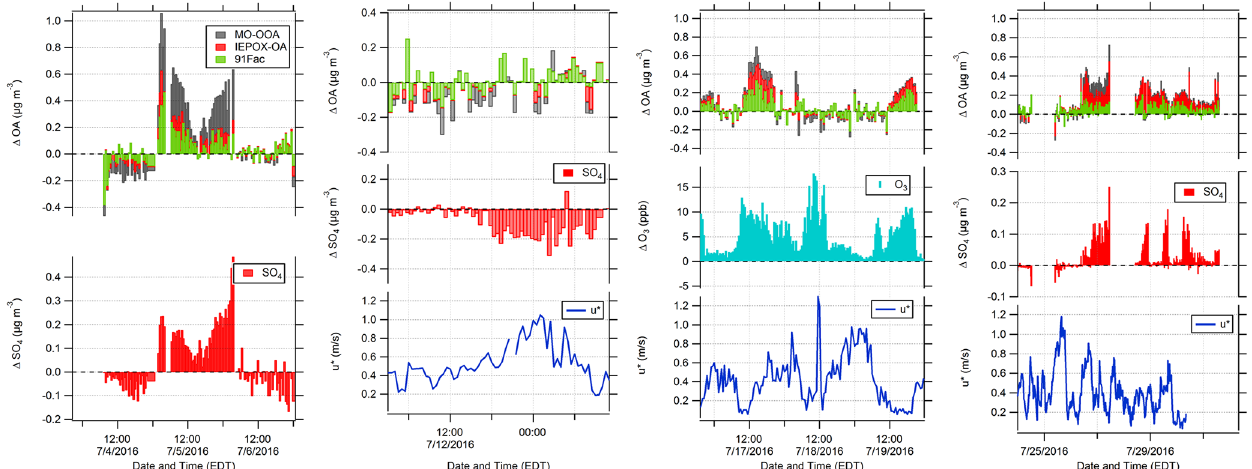
Figure 6. Time series of observed NR-PM 1 vertical-difference episodes: (from left to right) Episode 1, Episode 2, Episode 3, and Episode 4. Data shown for Episode 1, Episode 2, and Episode 4 include vertical differences in 30min averaged above- and below-canopy SO 4 , while data shown for Episode 3 show vertical differences in 30min averaged above- and below-canopy O 3 . The O 3 data were measured from the AmeriFlux Tower at 6 and 27m and were provided courtesy of CU Boulder. Friction velocity measurements at 29m on the PROPHET tower are also provided for Episodes 2–4. The date format is